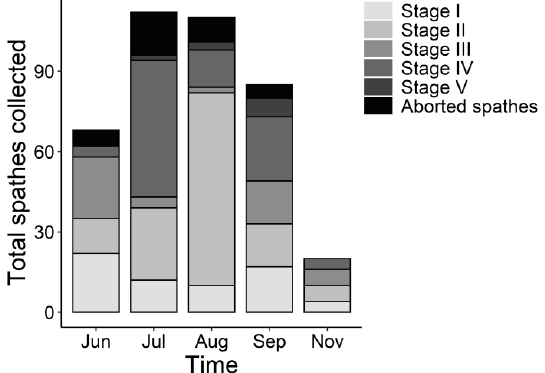
Figure 4. General reproductive phenology of the studied Z. noltei meadows of the Ria de Aveiro lagoon.